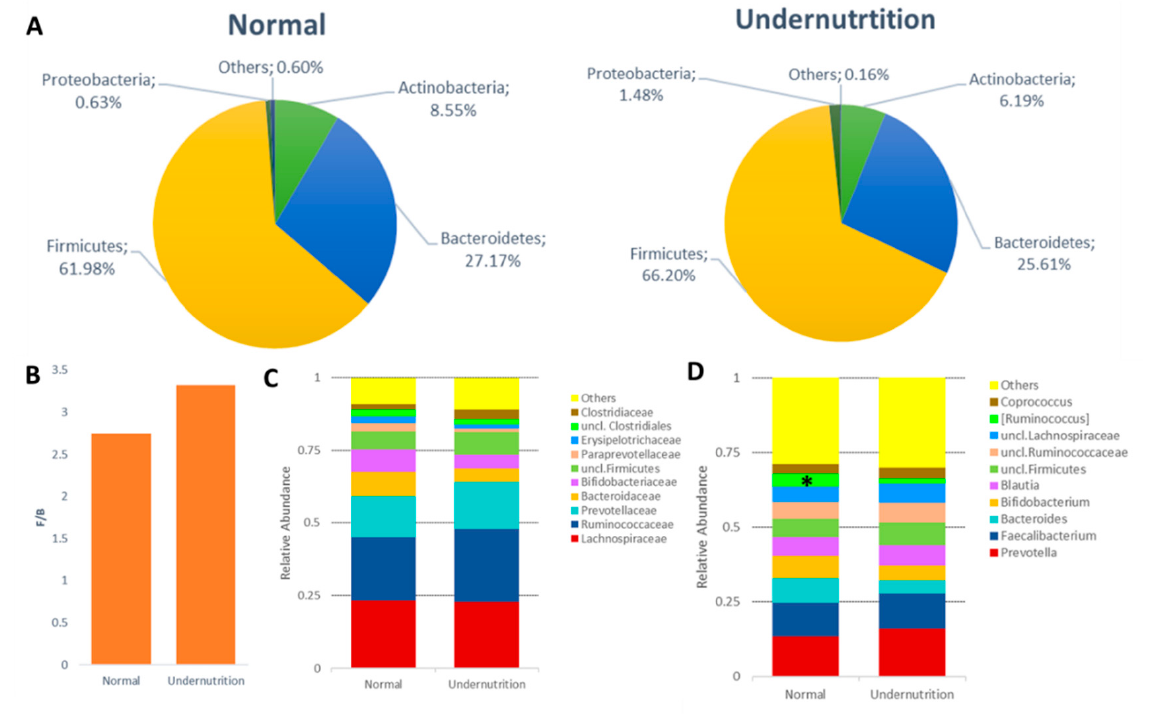
Figure 3. Gut microbiota profile between normal and undernutrition group. ( A ) The difference in the phylum level of gut microbiota between normal and undernutrition groups. ( B ) Firmicutes and Bacteroidetes ratio (F/B) between normal and undernutrition group. ( C ) top 10 relative abundance of family between the group. ( D ) top 10 relative abundance of genus between the group. * means significantly different ( p < 0.1).